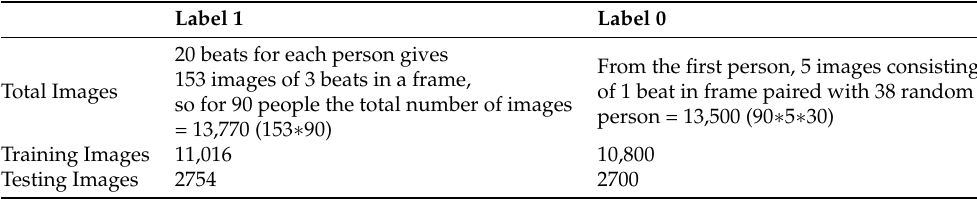
Table 6. Description of the number of training and testing patterns with three beats as a single